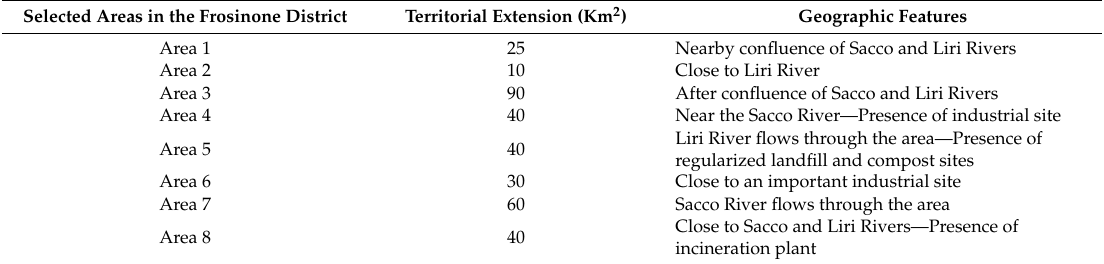
Table 2. Geographic features of selected areas (modified from Reference